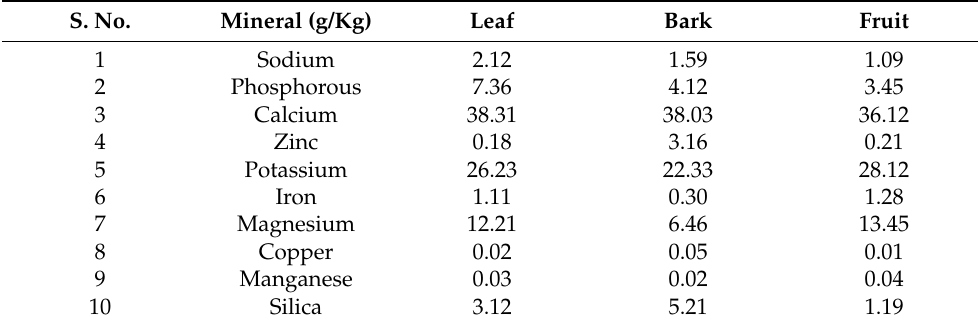
Table 2. Composition of minerals from different parts of E. laevis .